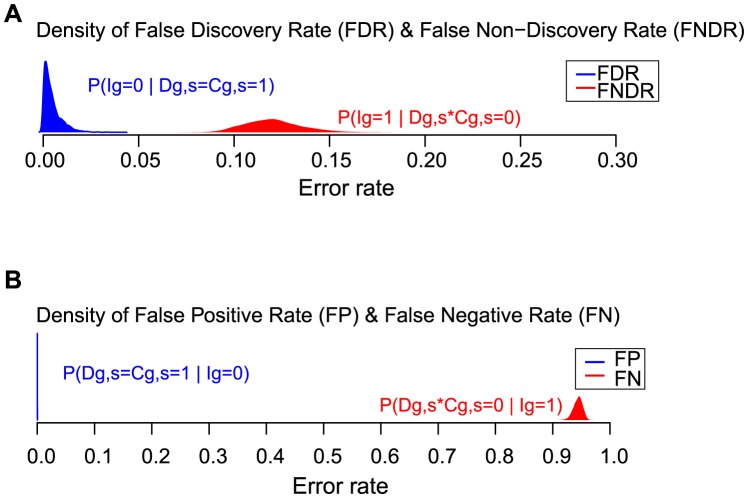
False negative rate exceeds false positive rate.
A) Posterior distributions of false discovery rate (FDR) and false non-discovery rate (FNDR) estimated by Markov chain Monte Carlo using multi-study influenza RNAi data and the statistical model of multi-study agreement. The false positive rate FDR is the probability that a gene is not truly involved (Ig = 0) if it is confirmed in one study, not accounting for what may happen in other studies. Similarly the false negative rate FNDR is the probability that a gene is truly involved (Ig = 1) if it is not confirmed Evidently the false negative rate is higher than false positive rate according to these posterior distributions. B) Similar to Panel A, though false positive (FP) and false negative (FN) rates are defined relative to the true gene involvement status rather than to lists of confirmed genes.